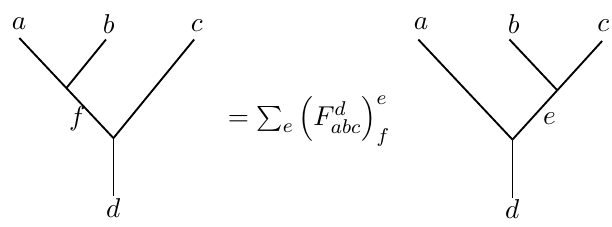
Figure 2 . Pictorial definition of the F-matrix.